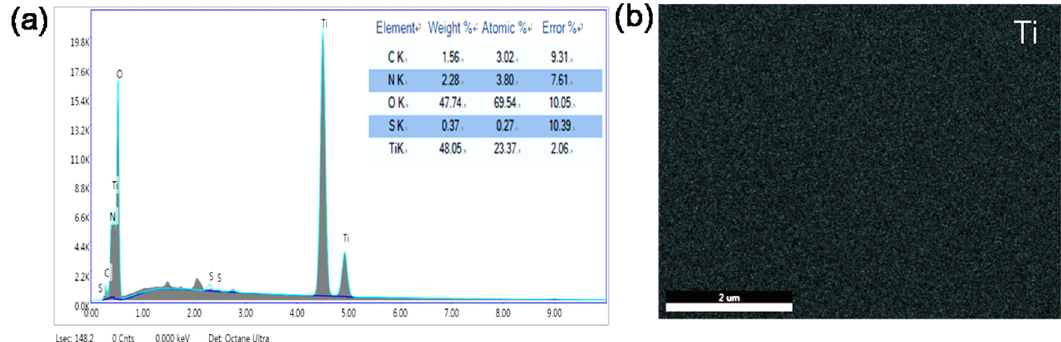
Figure 5. ( a ) EDX spectrum of the NGRT@AC-PSF membrane ( b ) and an EDX map of Ti in the NGRT@AC-PSF membrane.